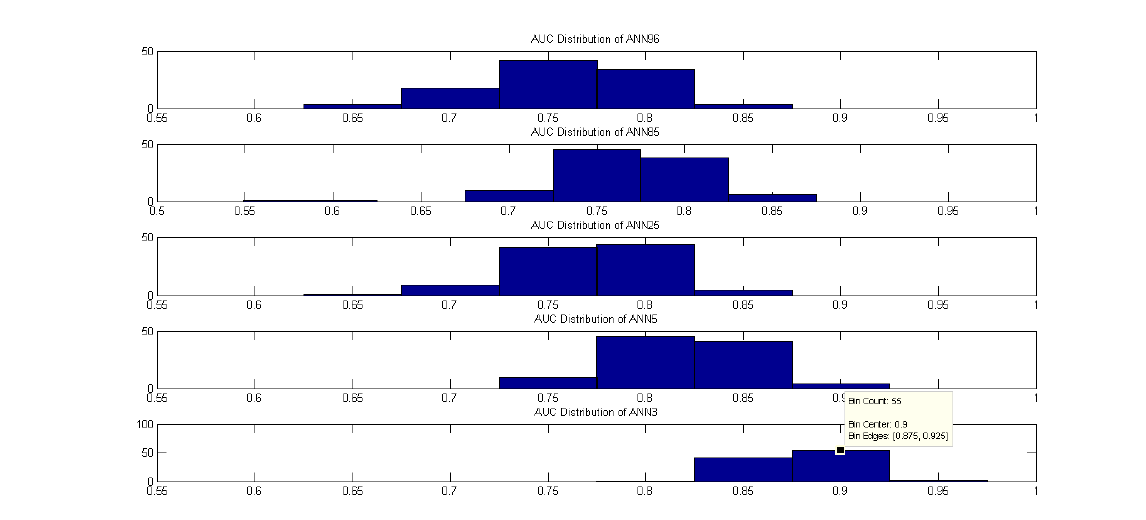
Figure 8. AUC distribution for each ANN to diagnose using the IDF